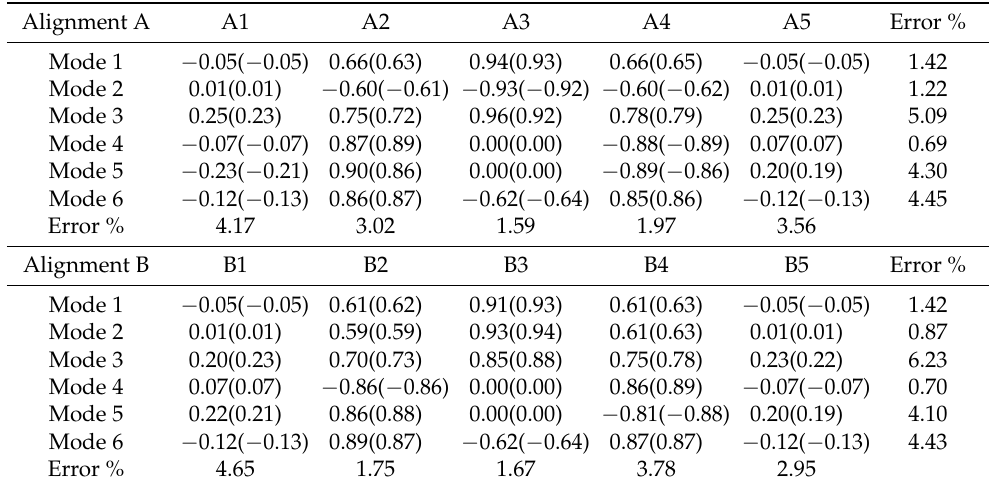
Table 6. Mode values evaluate through OMA and Numerical Identification (in